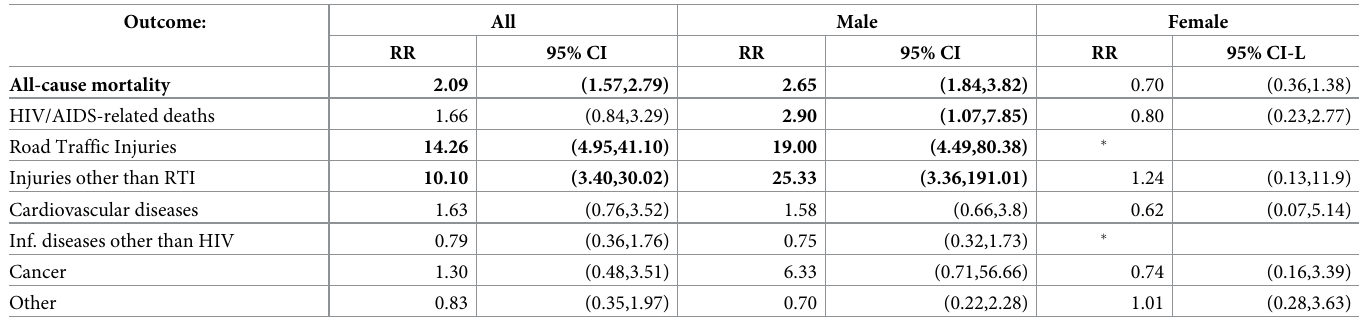
Table 4. Relative risk of cause-specific mortality among mining workers living in the surveillance area. Outcome: